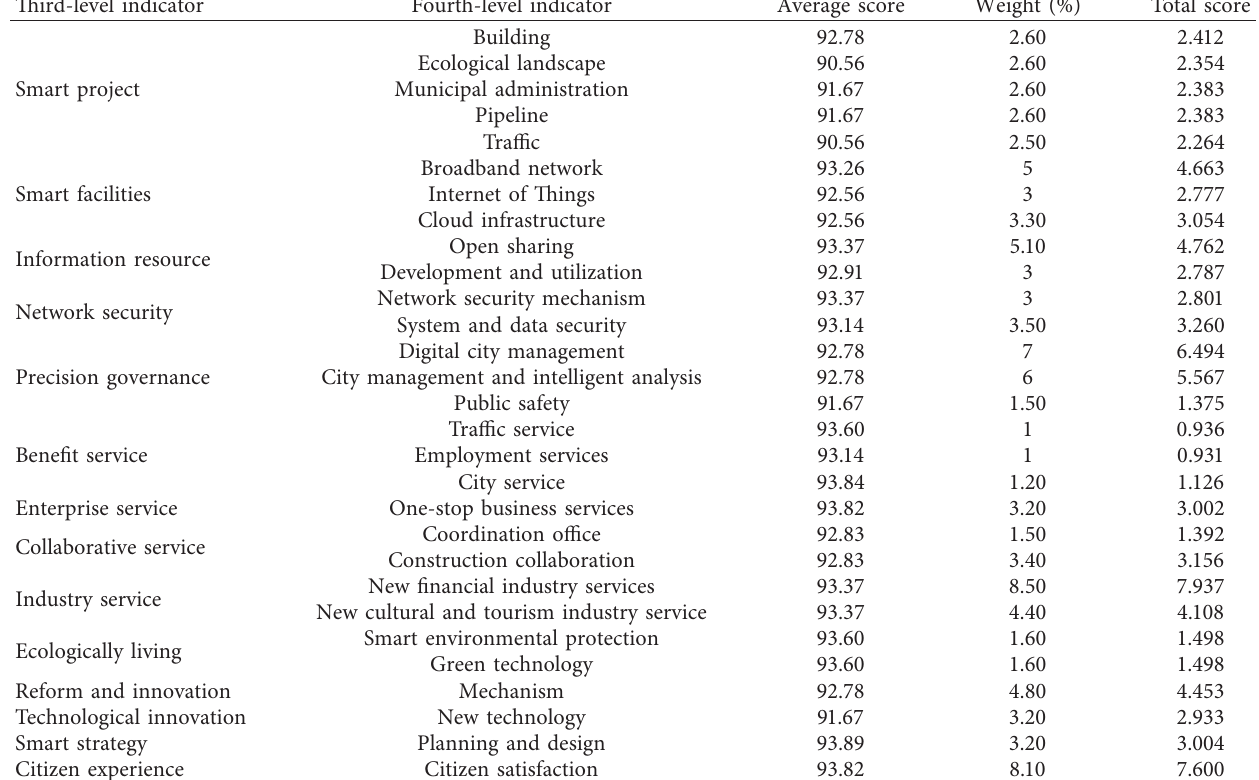
Table 8: Comprehensive rating form for the CBD in the Jiangbei New